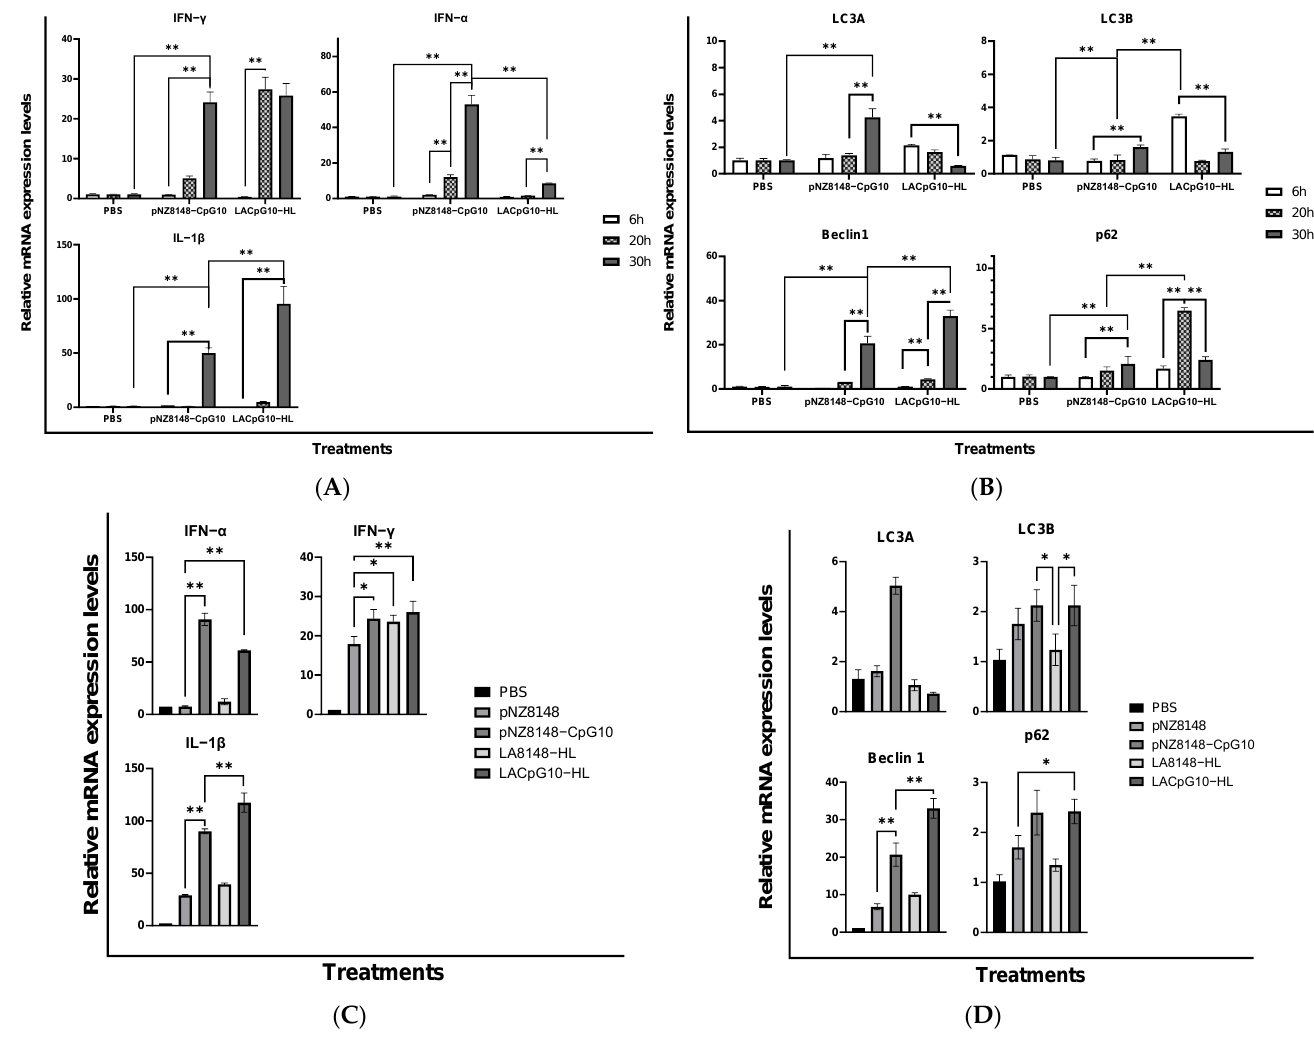
Figure 1. Immunostimulatory effects of LACpG10-HL on chicken lymphocytes. Chicken lympho- cytes were stimulated by PBS, pNZ8148-CpG10, and LACpG10-HL at different time points to detect the relative mRNA level of cytokines ( A ) and autophagy proteins ( B ). Afterward, two more control stimulants, including pNZ8148 and LA8148-HL, were added to further confirm the efficacies of LACpG10-HL at 30 h ( C , D ). These data were presented as the relative expression ratio with normalization to β -actin. Each column is represented with mean ± SD from three repeated experiments. Significant differences between different treatments were indicated by “*” (* p < 0.05, ** p < 0.01).